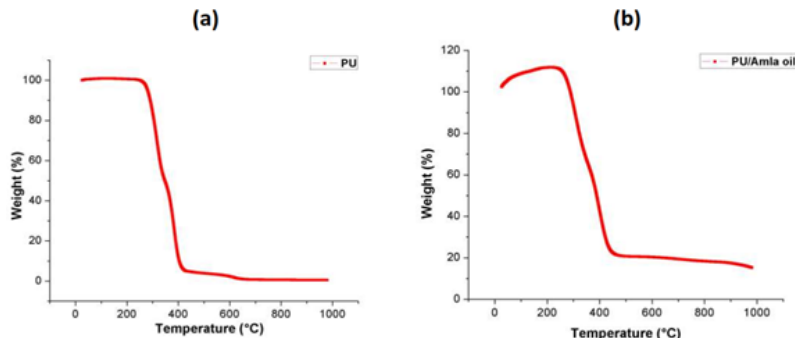
Figure 4. TGA analysis of (a) PU membrane (b) PU/Amla oil nanocomposites.